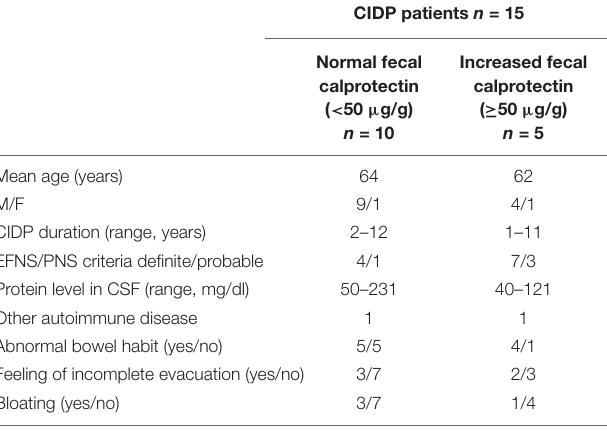
TABLE 1 | Demographic and clinical characteristics of the recruited CIDP patients.